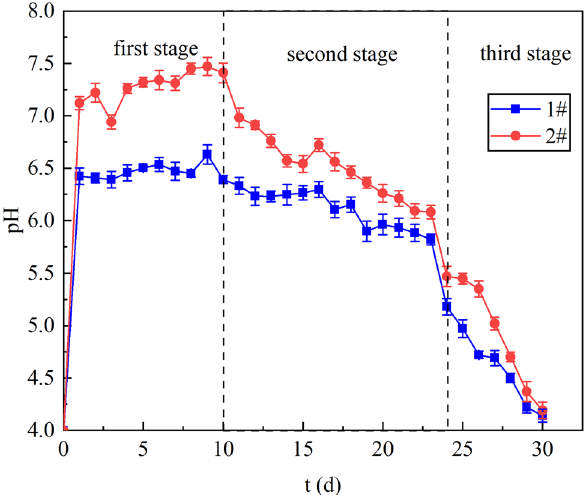
Figure 4. pH enhancement effect in dynamic columns 1# and 2#.